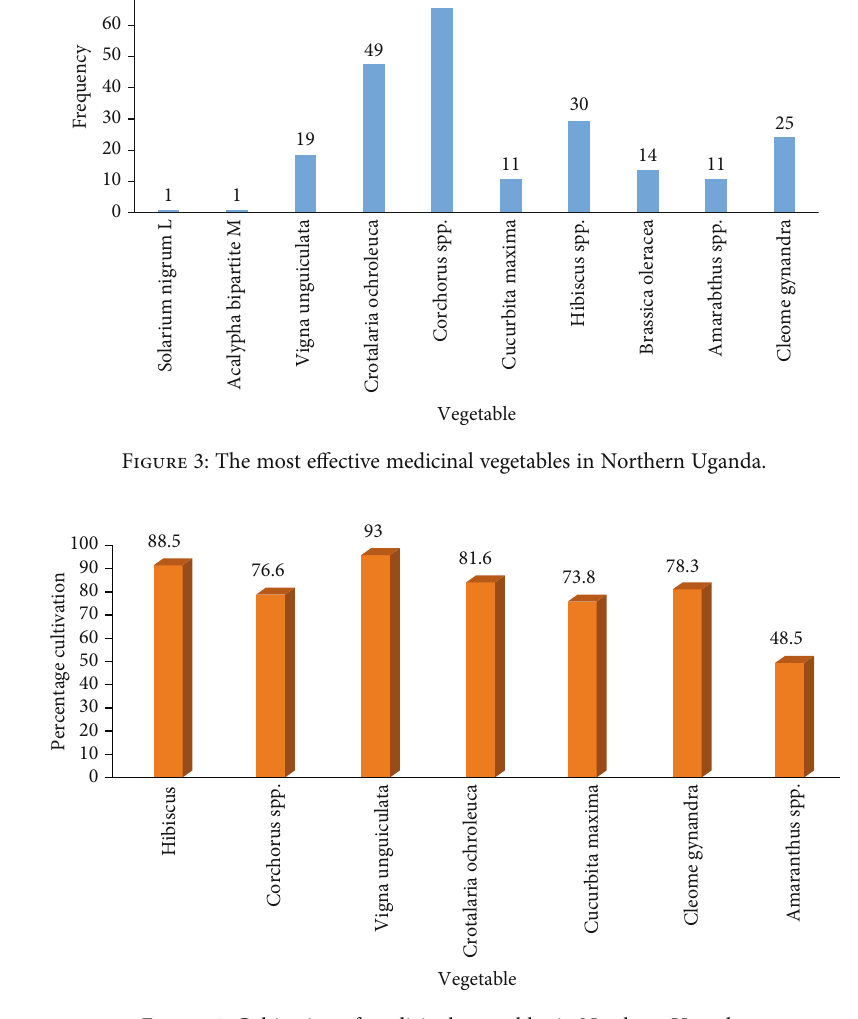
Figure 4: Cultivation of medicinal vegetables in Northern